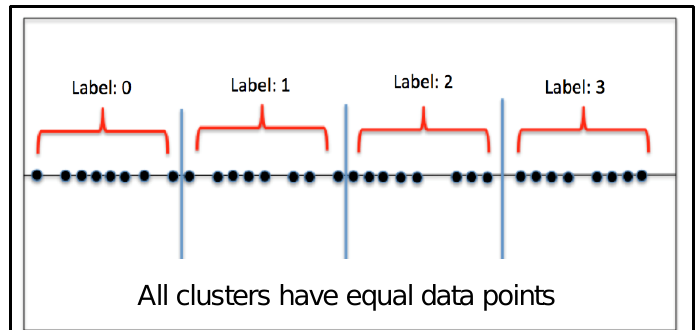
Figure 3. Quantile-based clustering for initial labelling of 𝑙 𝑝 values.